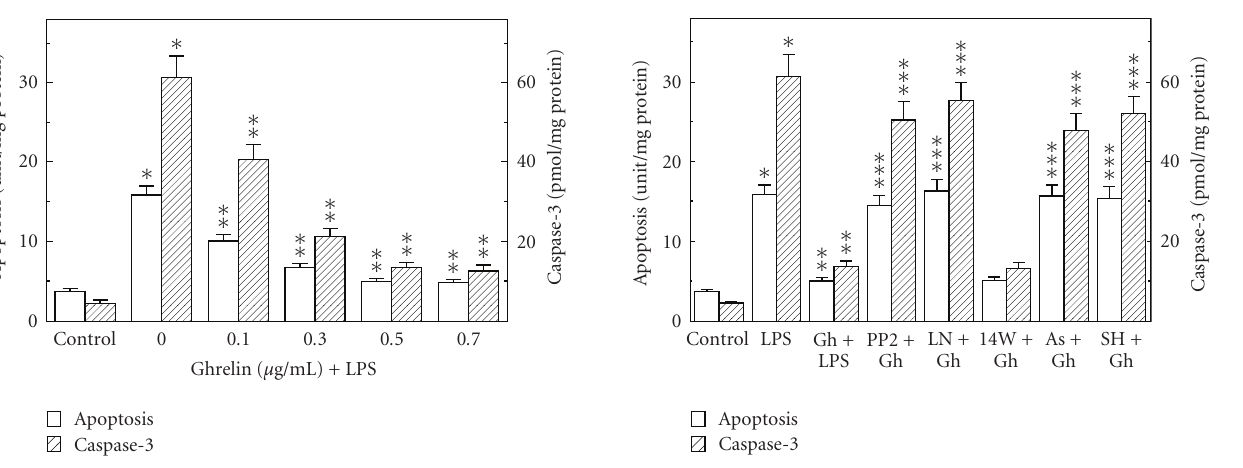
Figure 3: E ff ect of ghrelin on H. pylori LPS-induced gastric mucosal cell apoptosis and the activity of caspase-3. The cells, preincubated with the indicated concentrations of ghrelin, were treated with the LPS at 100 ng/mL and incubated for 16h. Values represent the means ± SD of five experiments. ∗ P < . 05 compared with that of control. ∗∗ P < . 05 compared with that of LPS alone.